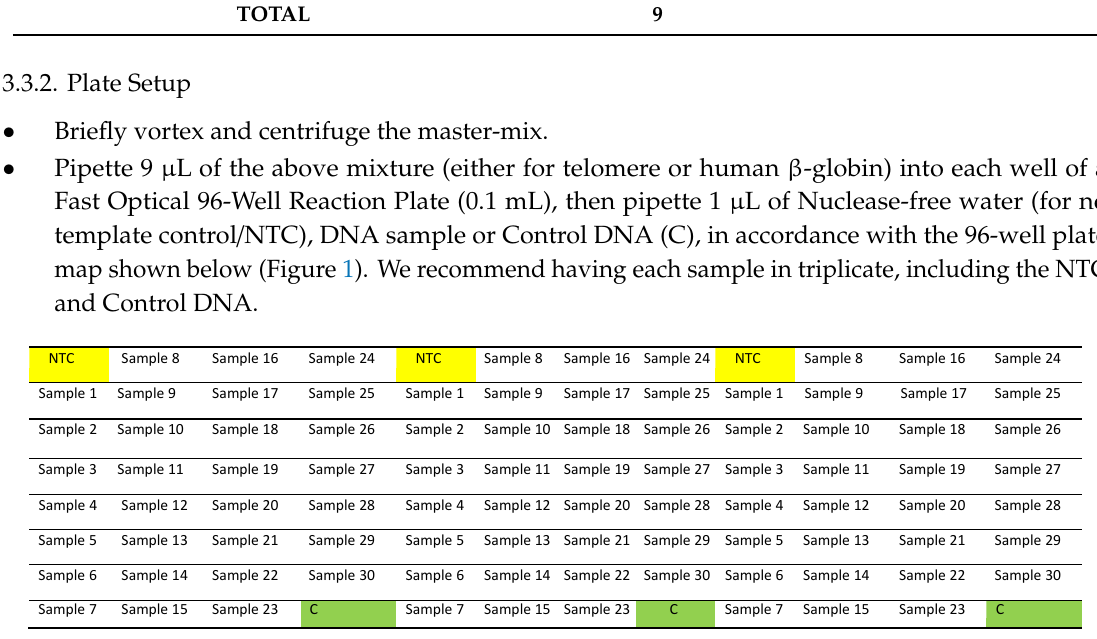
Figure 1. PCR plate map. A template of 96-well plate for telomere PCR that accommodates triplicates of no template control (NTC), 30 samples, and Control DNA (C) in different positions as indicated. Exact same PCR is setup for single-copy gene (human β-globin) with identical well positions for NTC, samples, and Control DNA.